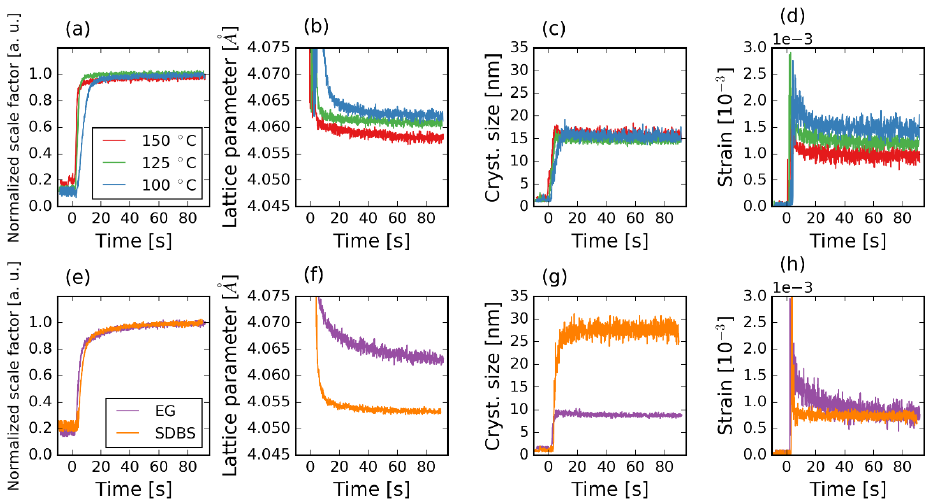
Figure 2. Time resolved refined values for the experiments with the Ti-slurry, showing scale factor ( a , e ), lattice parameter ( b , f ), crystallite size ( c , g ), and strain ( d , h ): ( a – d ) Ti-slurry-150, Ti-slurry-125, and Ti-slurry-100; ( d – g ) Ti-slurry-EG and Ti-slurry-SDBS at 125 °C. Scale factor is normalized to last